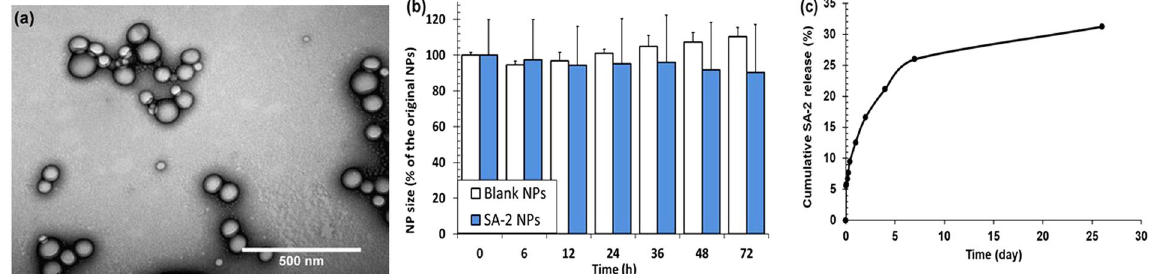
Figure 6. Characterization of SA-2 NPs. ( a ) Transmission electron microscopic (TEM) image, ( b ) stability in serum at